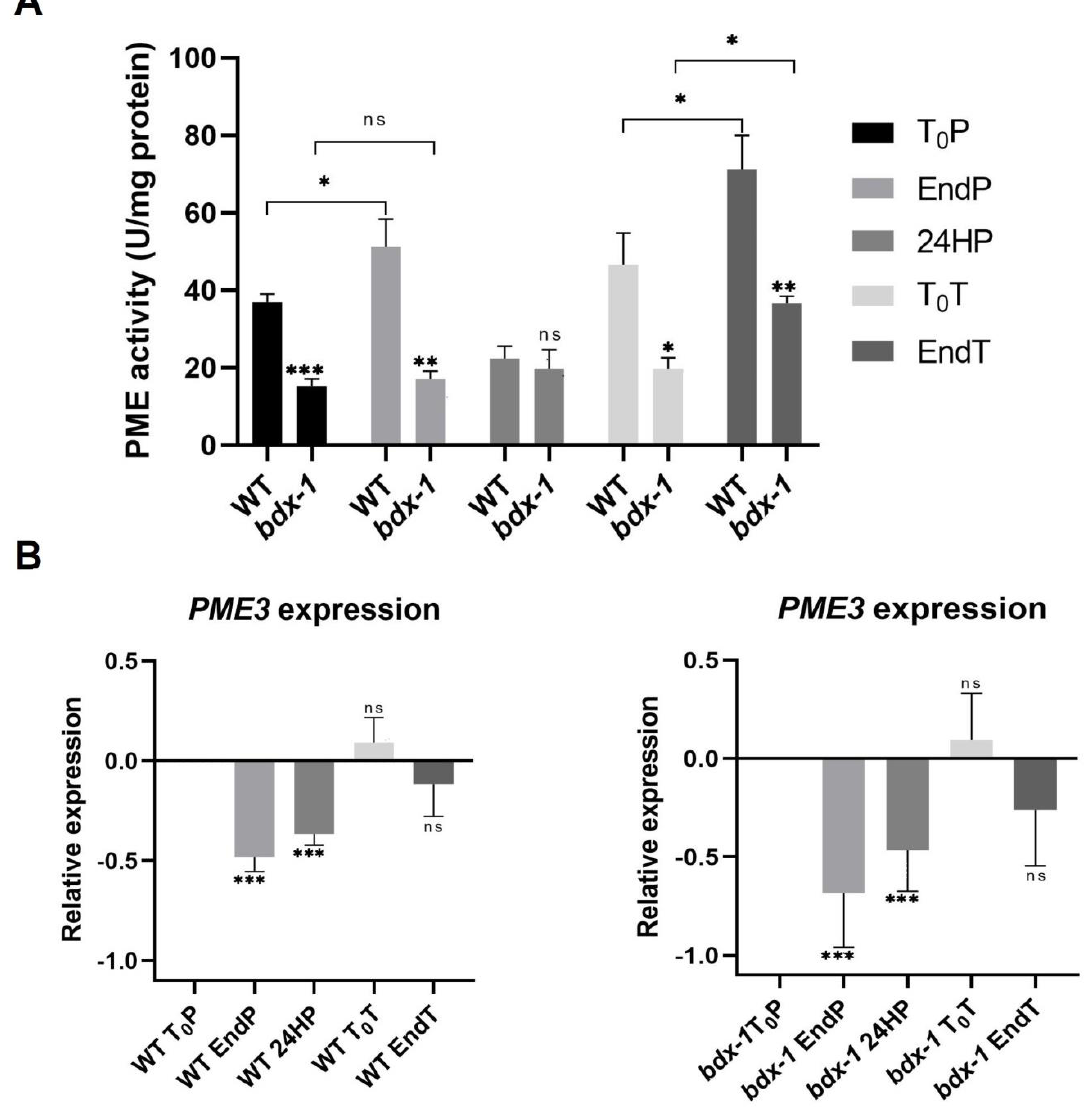
Figure 4. PME activity and AtPME3 expression of WT and bdx -1 lines during thermotolerance and thermomemory. ( A ) Effect of priming and triggering on the total PME activity of WT and bdx -1 seedlings. Error bars indicate SEM (n = 4). Statistical analyses were performed using Student’s t -test. Asterisks indicate statistically significant differences between WT and bdx -1 and between treatments (* p < 0.05, ** p < 0.01, *** p < 0.001). ( B ) Effect of priming and triggering on expression levels of AtPME3 in WT and bdx -1 seedlings. The expression values are relative to T 0 P expression. Error bars indicate S.D. (n = 3). Statistical analyses were performed using Student’s t -test. Asterisks indicate statistically significant differences to T 0 P (* p < 0.05, ** p < 0.01, *** p < 0.001, ns, not